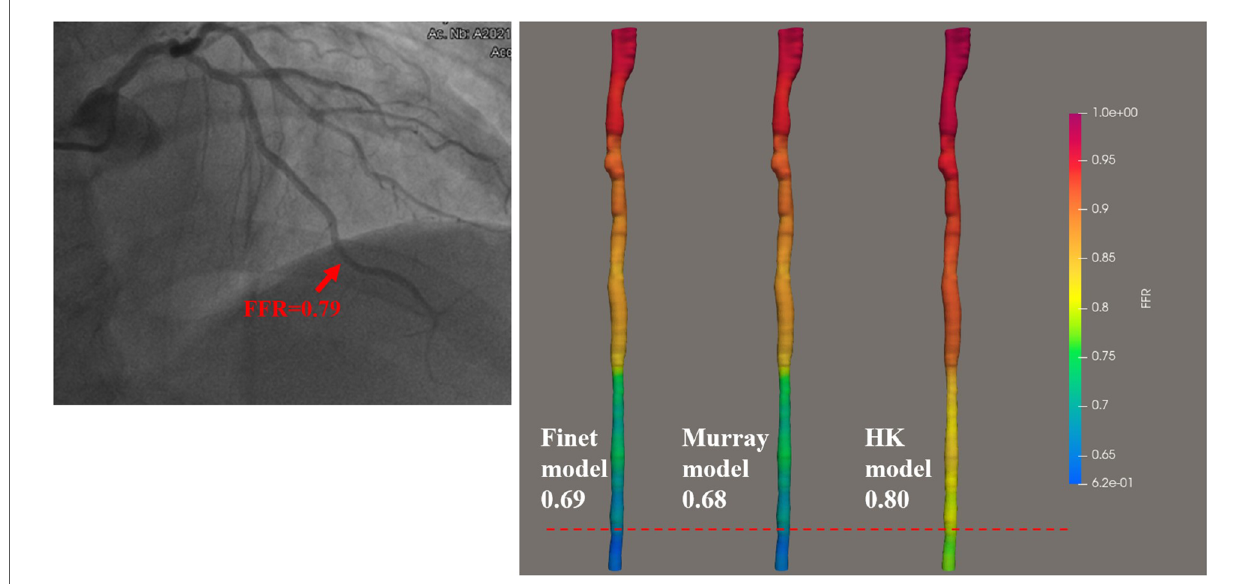
FIGURE 9 Examples of the calculated results for the Finet model, Murray model, and HK model. The image on the left shows the angiography image of the patient and the invasive FFR markers at the location of the lesion. The right panel shows the calculated results of the three models, respectively. It can be seen that the HK model has the highest accuracy.